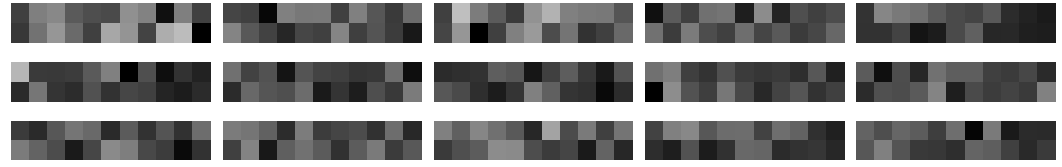
Figure 25. An example of fifteen processed image formed in the fourth step.